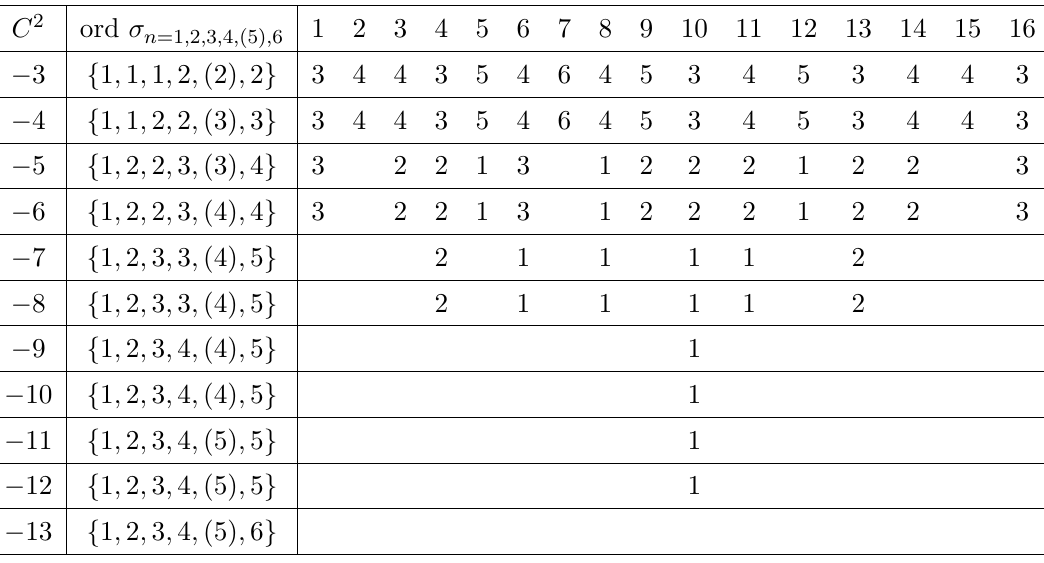
Table 1 . Curves C with self-intersection C (cid:1) C that are allowed in the base of a stacked F -(cid:12)bered polytope for the 16 (cid:12)ber types F . The numbers below the labels of the 16 (cid:12)ber types count the numbers of the vertices of F that give vertex stacked-form (cid:12)brations where the corresponding curve can appear in the base. (Note that (cid:0) 3 and (cid:0) 4 curves are allowed in all cases, so the (cid:12)rst and second rows give the total number of the vertices of a given (cid:12)ber, and the most negative curve that can occur for a given (cid:12)ber corresponds to the position of the last non-empty entry in the column.) The second column gives the orders of vanishing of (cid:27) n 2 O ( (cid:0) nK ) along C , n = 1 ; 2 ; 3 ; 4 ; (5) ; 6 (none of the (cid:12)bered polytopes has O ( (cid:0) nK ) for either n (cid:21) 7 or n = 5). A (4 ; 6) singularity arises along the whole curve unless there exists a section (cid:27) n 2 O ( (cid:0) nK ) such that ord C ( (cid:27) n ) < n . The existence of such a section depends on the (cid:12)ber type and the speci(cid:12)ed vertex of the base used for the stacking. Curves with (cid:0) 13 (cid:20) C (cid:1) C (cid:20) (cid:0) 3 are considered (while curves C 2 (cid:21) (cid:0) 2 are